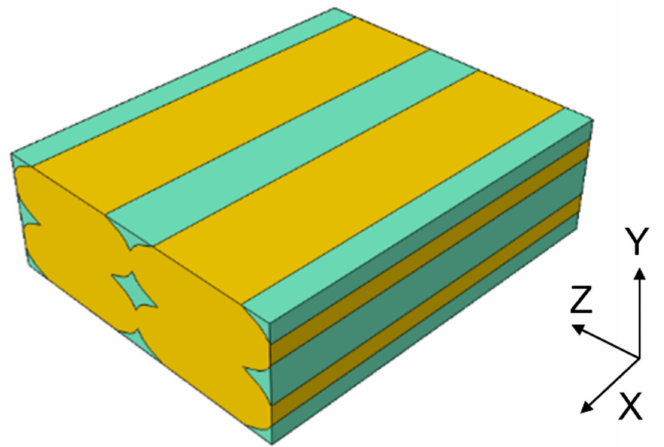
Figure 4. RVE model. The polylactic acid (PLA) mesostructure is indicated in yellow, and air is indicated in green.